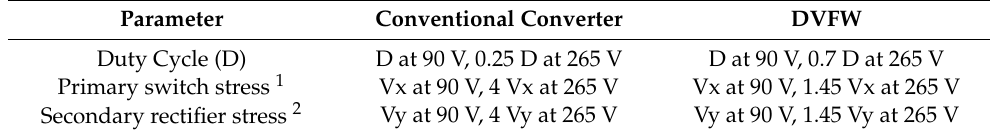
Table 1. Comparison between conventional forward converter and DVFW.